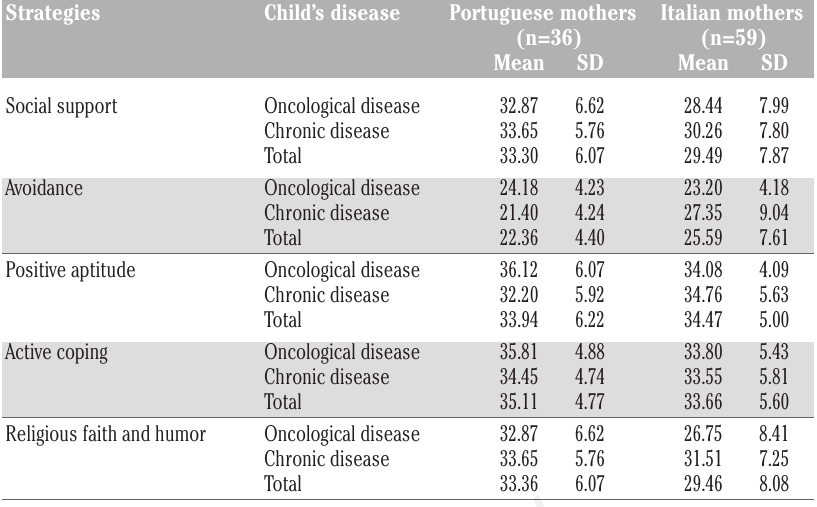
Table 3. Descriptive statistics